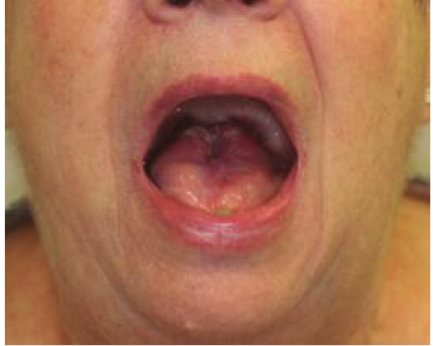
Figure 3: Appearance of the healed